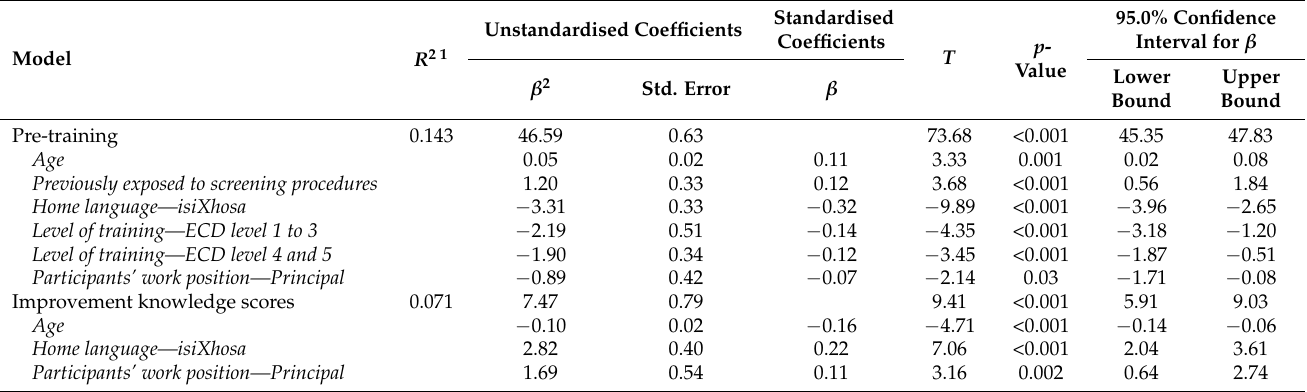
Table 4. Linear regression analysis results for pre-training and improvement knowledge